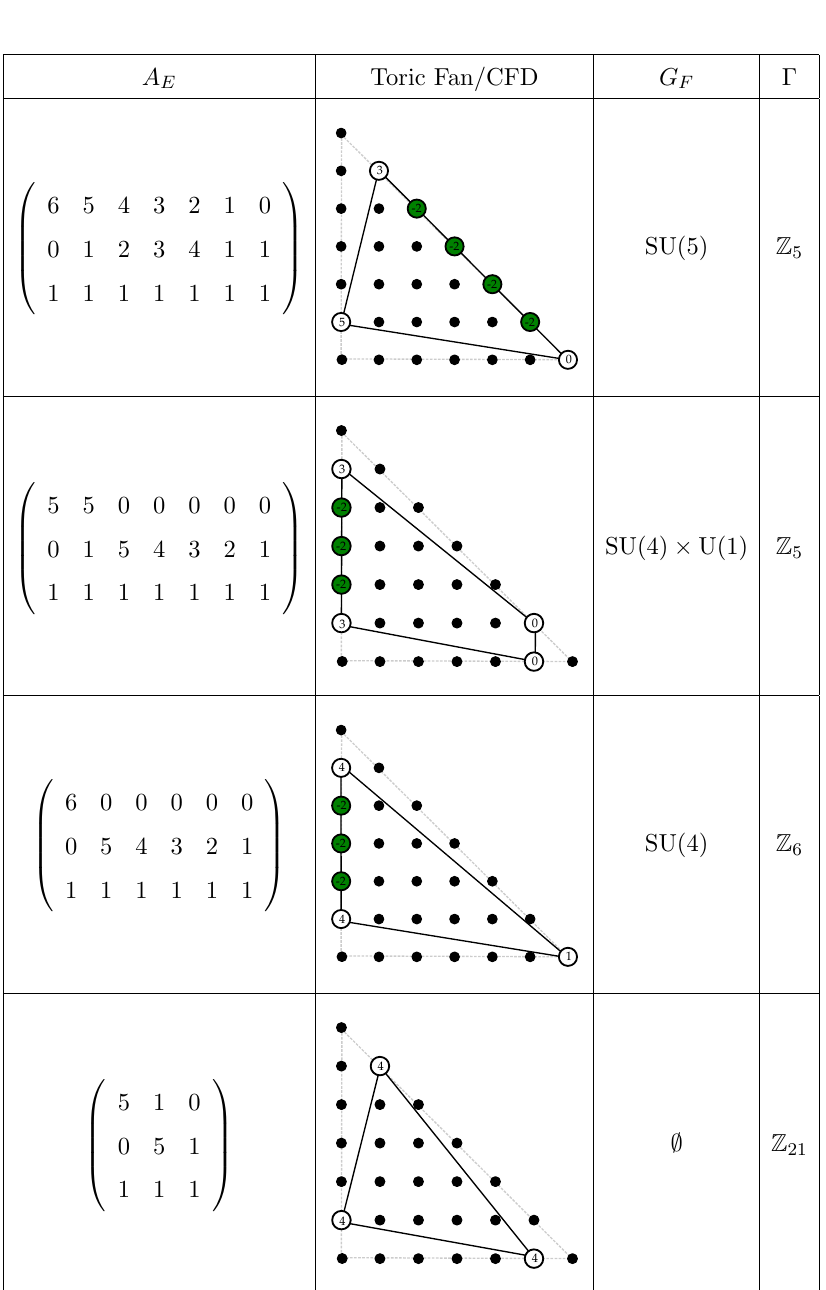
Table 3 . Descendants of the T 6 theory, which have non-trivial 1-form symmetry. First we give the CFD, (cid:13)avor symmetry is indicated by G F and (cid:0) is the 1-form symmetry.